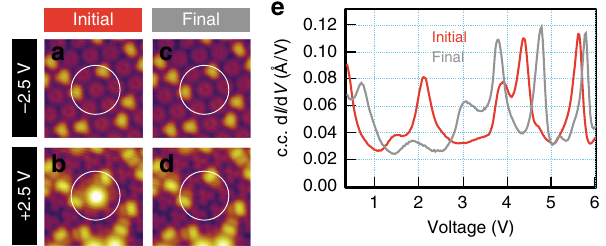
Fig. 5 Evidence of Li atom ejection. a – d STM images before and after a Li ejection event, with a and b bearing the hallmarks of a Li@C 60 molecule, whereas c and d correspond to an empty C 60 molecule. Besides the Li ejection from the fullerene marked with a circle, one can observe the induced rotation of a neighbouring molecule. e Constant-current d I /d V spectra of the target molecule before and after